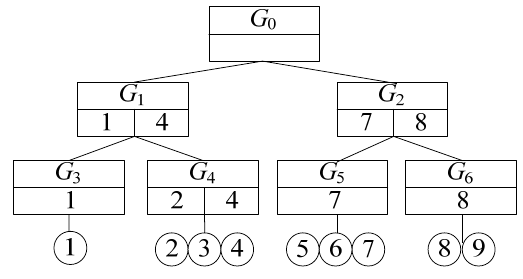
Figure A7. Example of the AP algorithm procedure. Table A10. Additional information in the G + -tree nodes. G + Tree Node G i